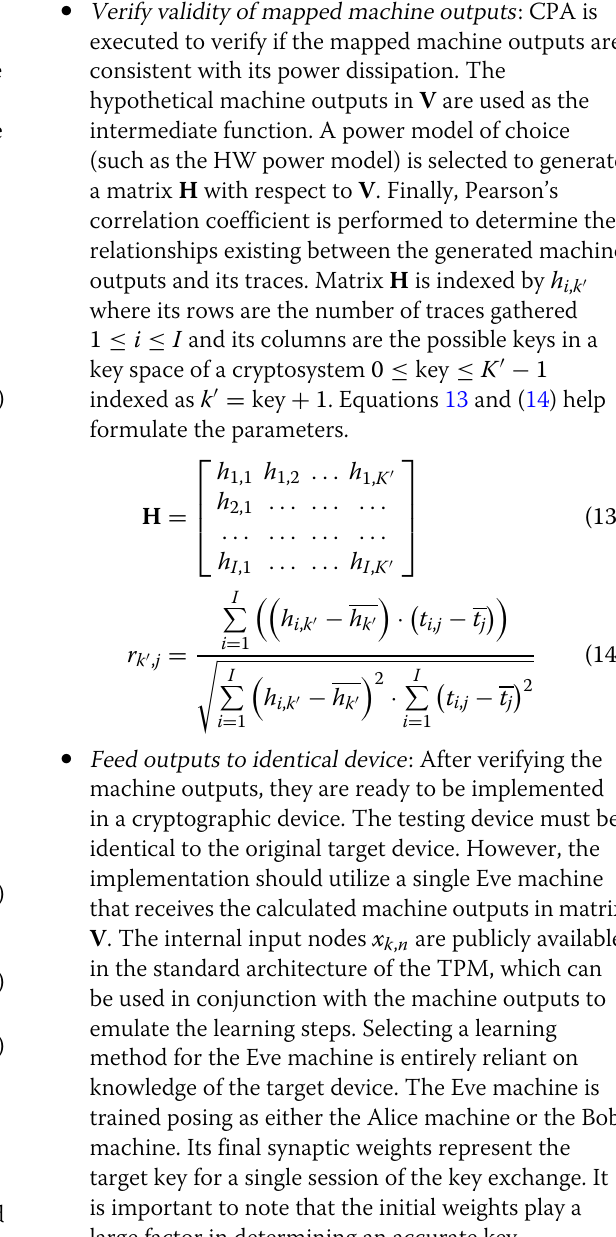
mentation in the ATMega328P microcontroller. Figure 7a shows how the absolute difference between the sam- ples in the recorded traces and its mean. The plot indi- cates that the maximum distance from the mean is seen between samples 840 ≤ j ≤ 860 while other local maximums of interest peak at j = 538 and j =